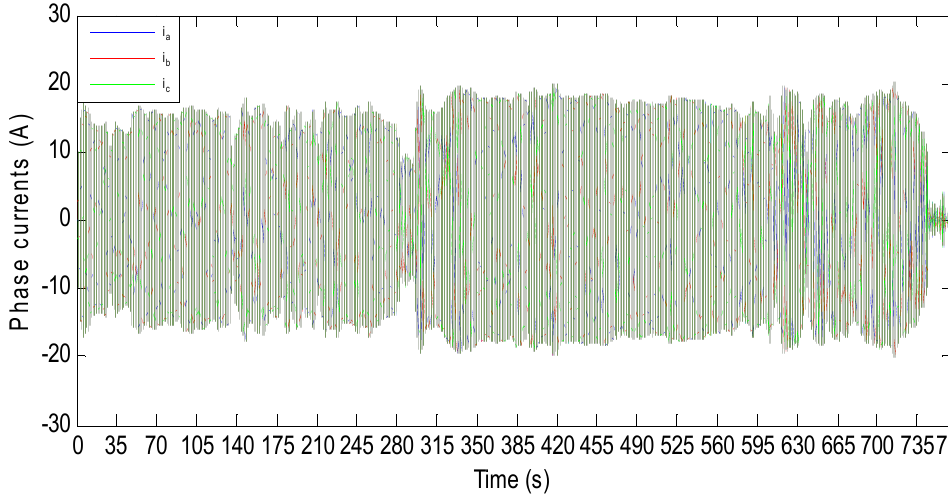
Figure 33. BEV torque absolute error for HWEFT driving cycle.